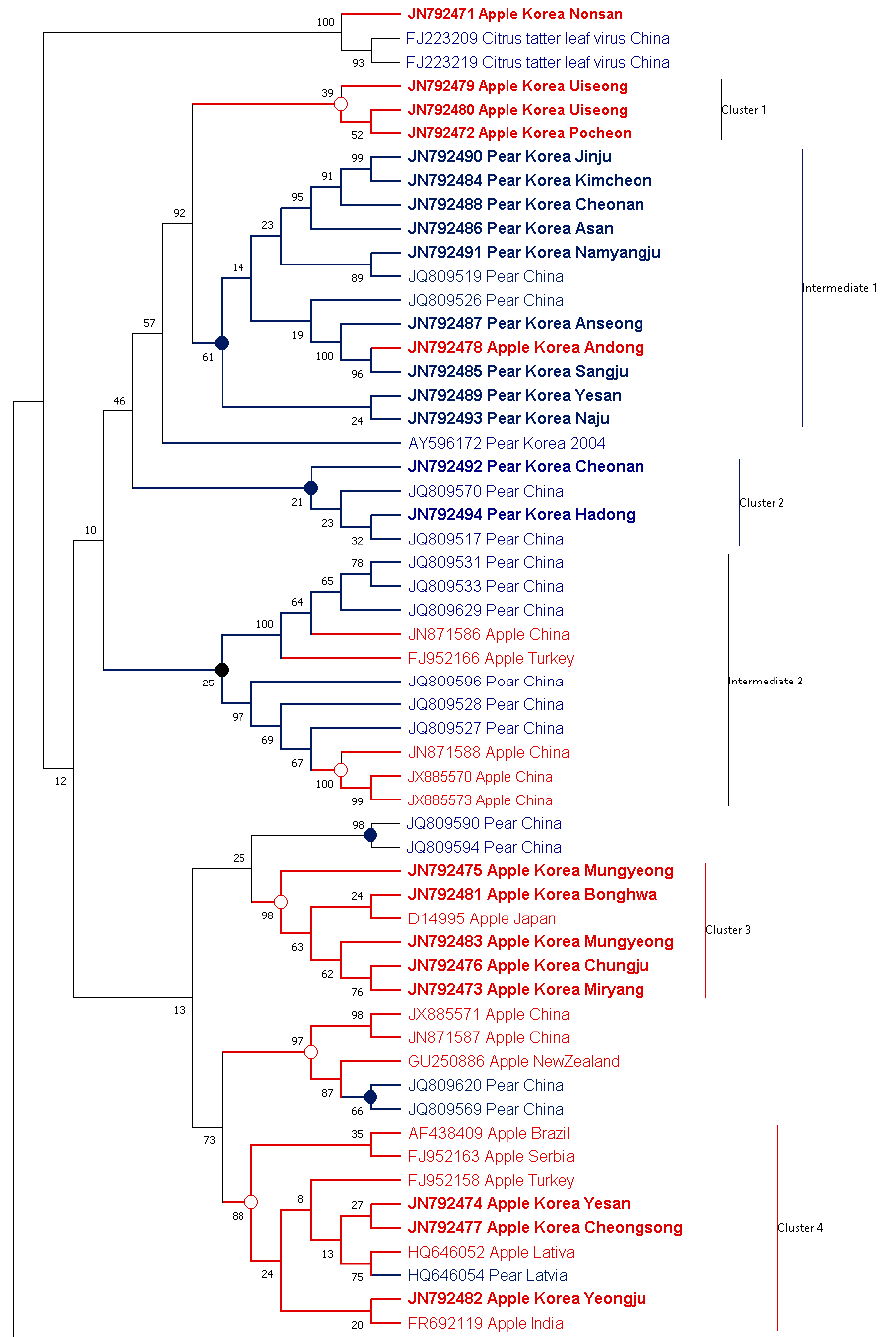
Figure 4. Phylogenetic analysis of apple stem grooving virus (ASGV) coat protein gene nucleotide. The tree is divided into distinct and intermediate clades. The Korean isolates identified in this study are shown with bold. Taxon names are color coded by isolation host (red for apple and blue for pear). The bootstrap support value is displayed on each branch node. The tree was generated using Maximum Likelihood with K2+G best-fit-model implemented in MEGAX.